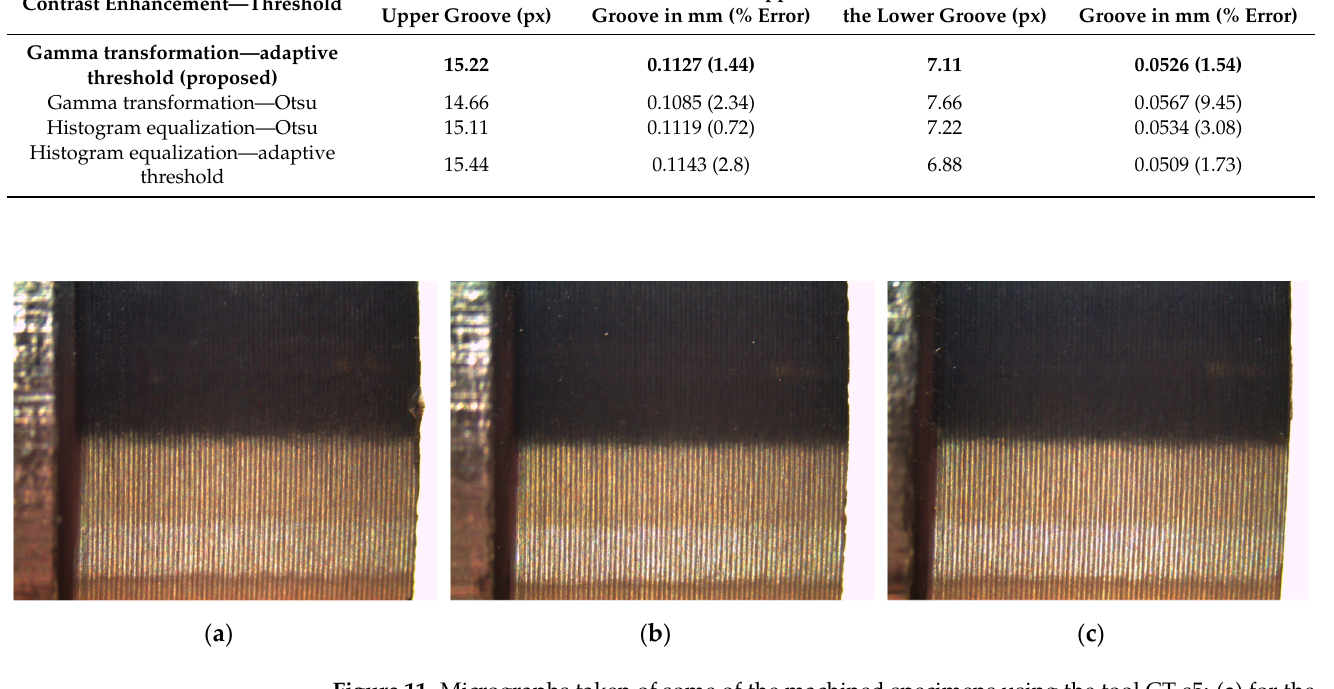
Table 6. Effectiveness results for the classification of tool wear with the use of the FFNN for the cutting speed tests.